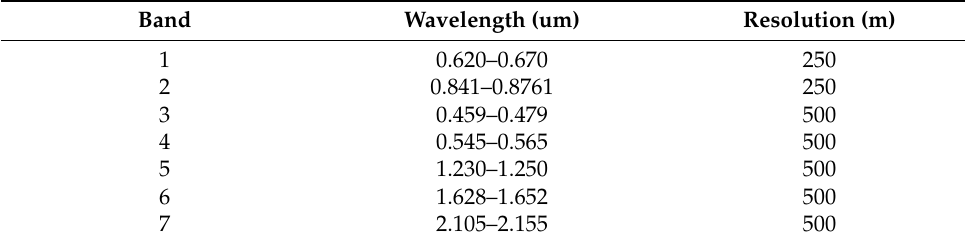
Table 2. Band parameters of